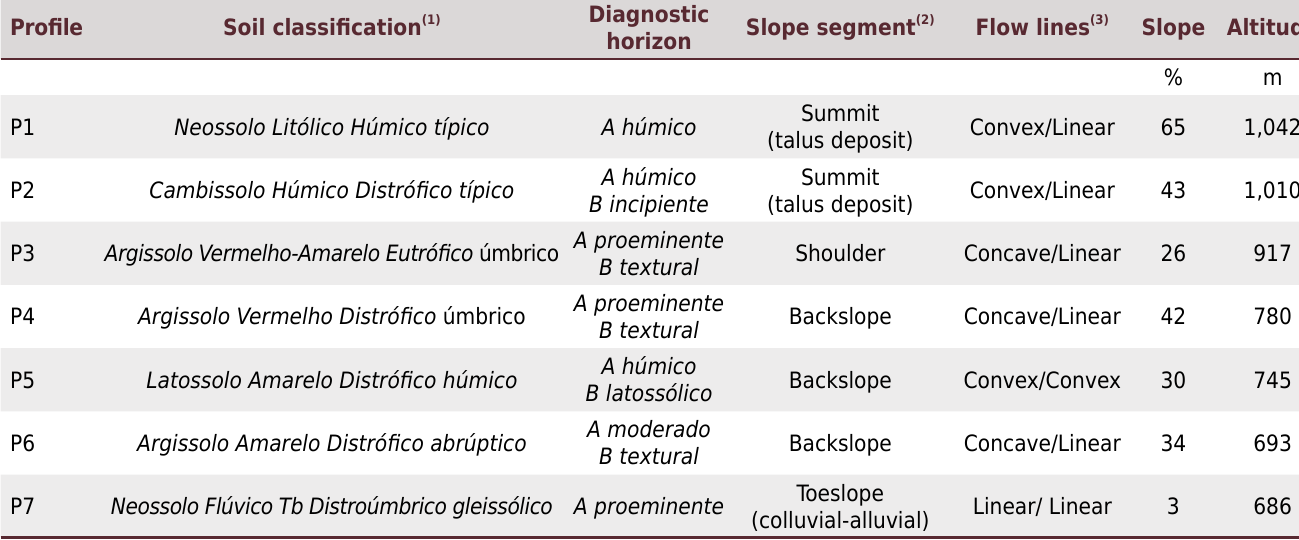
Table 1. Soil classification and landscape characterization in the Pito Aceso basin, municipality of Bom Jardim (RJ)